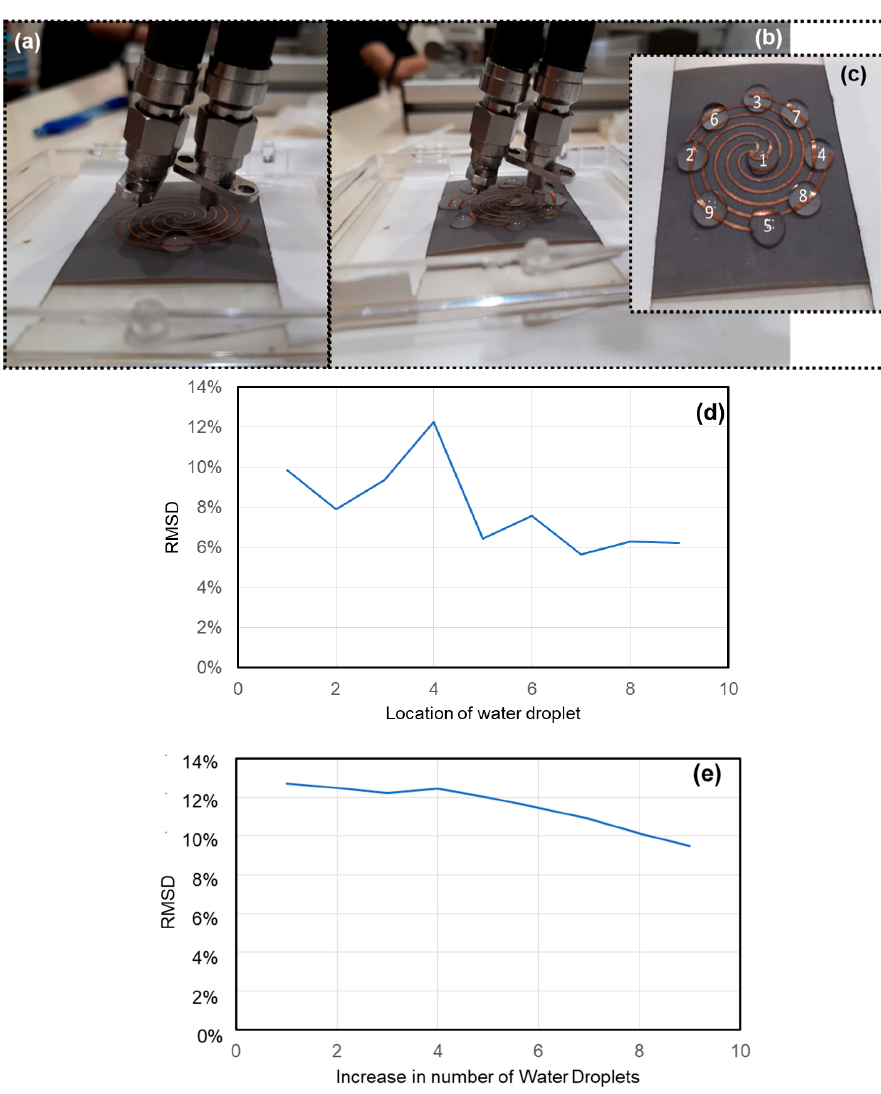
Figure 5. Spiral-LSP sensor and water effect ( a ) single water droplet on the sensor; ( b ) nine water droplets, dropped one after another; ( c ) order of dropping water droplets on the sensor; ( d ) RMSD variations when water droplets increase on the sensor; and ( e ) RMSD variations for water droplets at random locations.